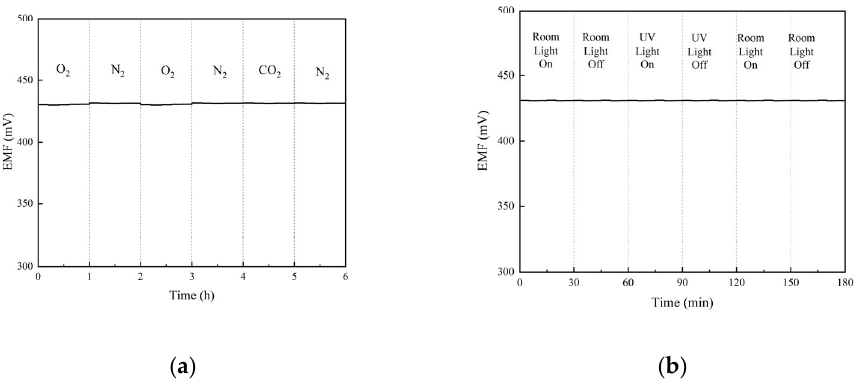
Figure 7. ( a ) The e ff ect of the presence of gases on the operation of sensors; ( b ) the e ff ect of the presence of light on the operation of sensors. presence of light on the operation of